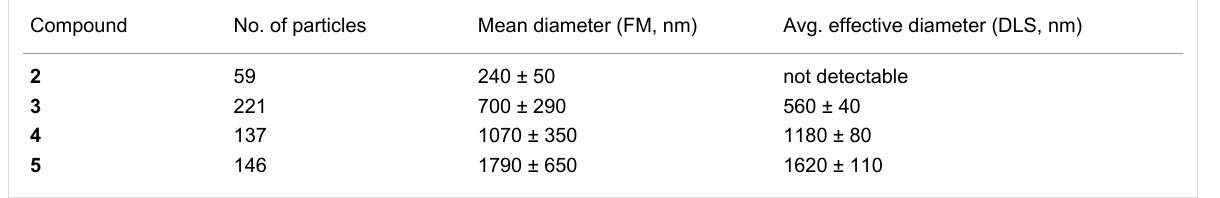
Table 1: Summary of aggregate characterization.